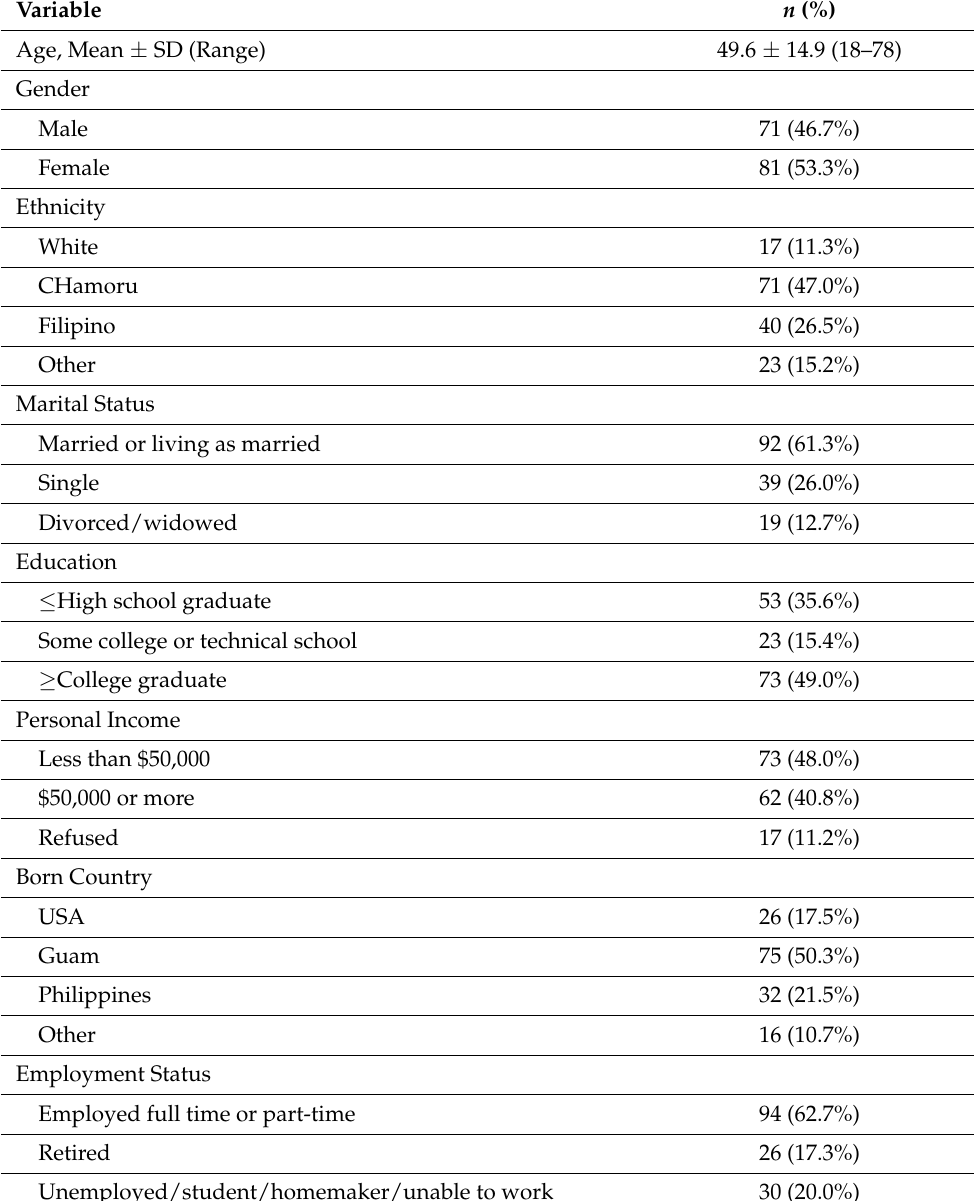
Table 1. Summary of Study Participant Demographic